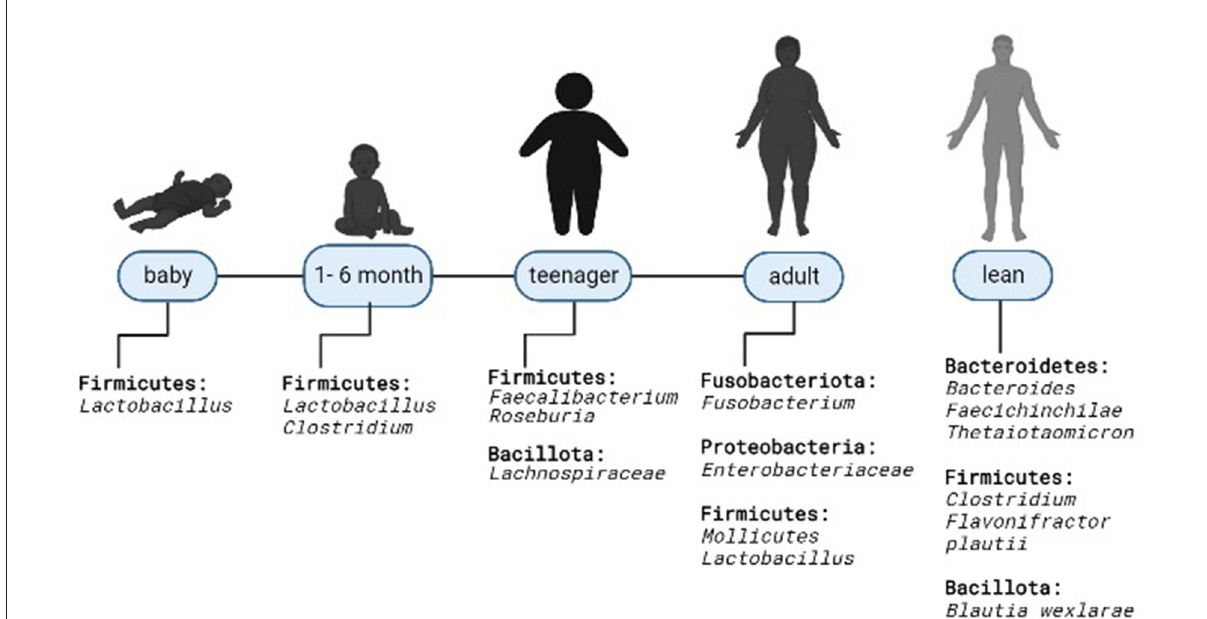
FIGURE1 Microbiota modification in overweight and obese humans. Predominant microbiota composition at the phylum and genus level in relation to